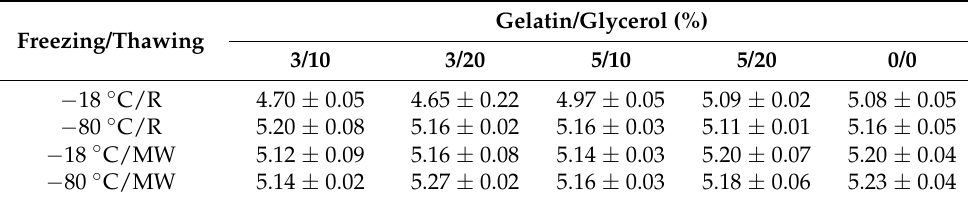
Table 3. pH ± SD values of coated and uncoated meat samples depending on the method of freezing and